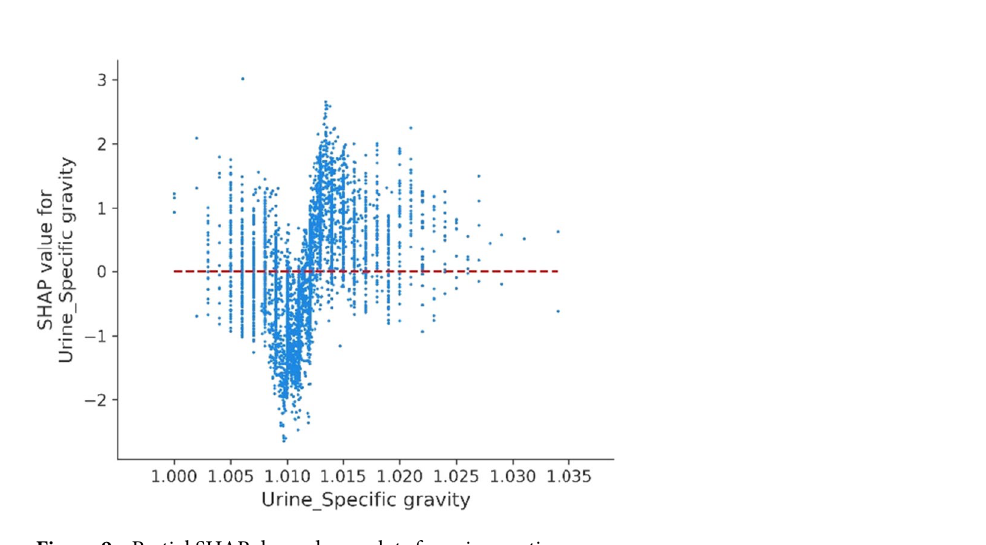
Figure 9. Partial SHAP dependence plots for urine